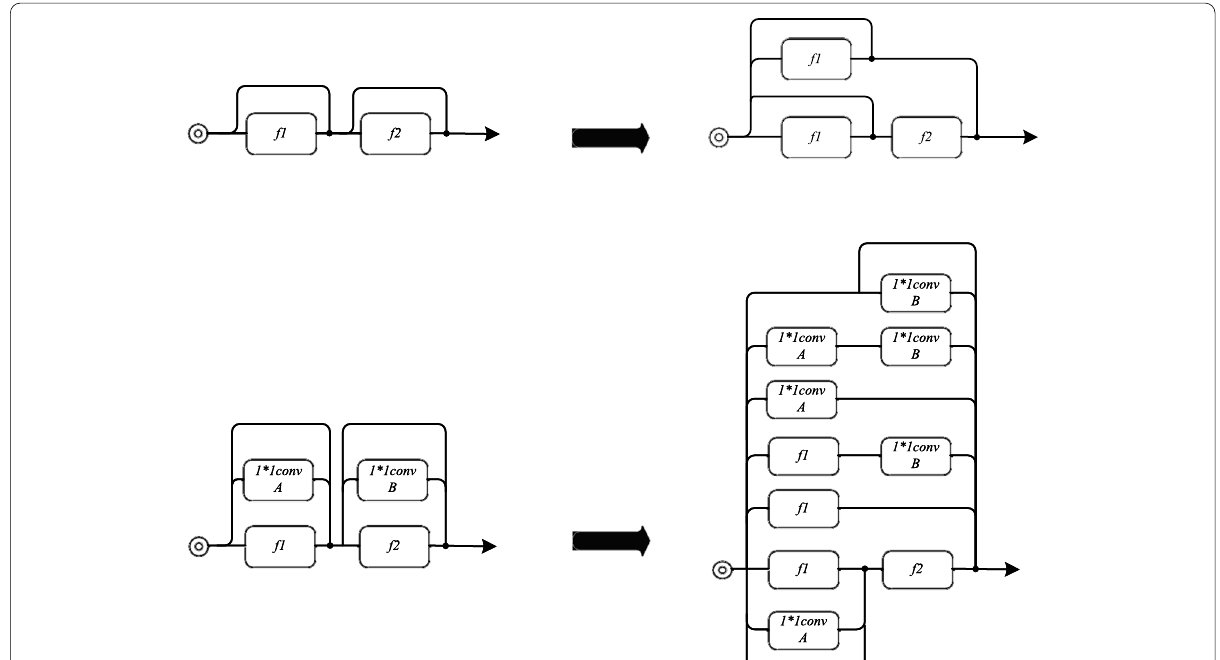
Fig. 1 Multi-branch structure expansion diagram, multi branch network of two Residuals Blocks(top), multi branch of two Repvgg